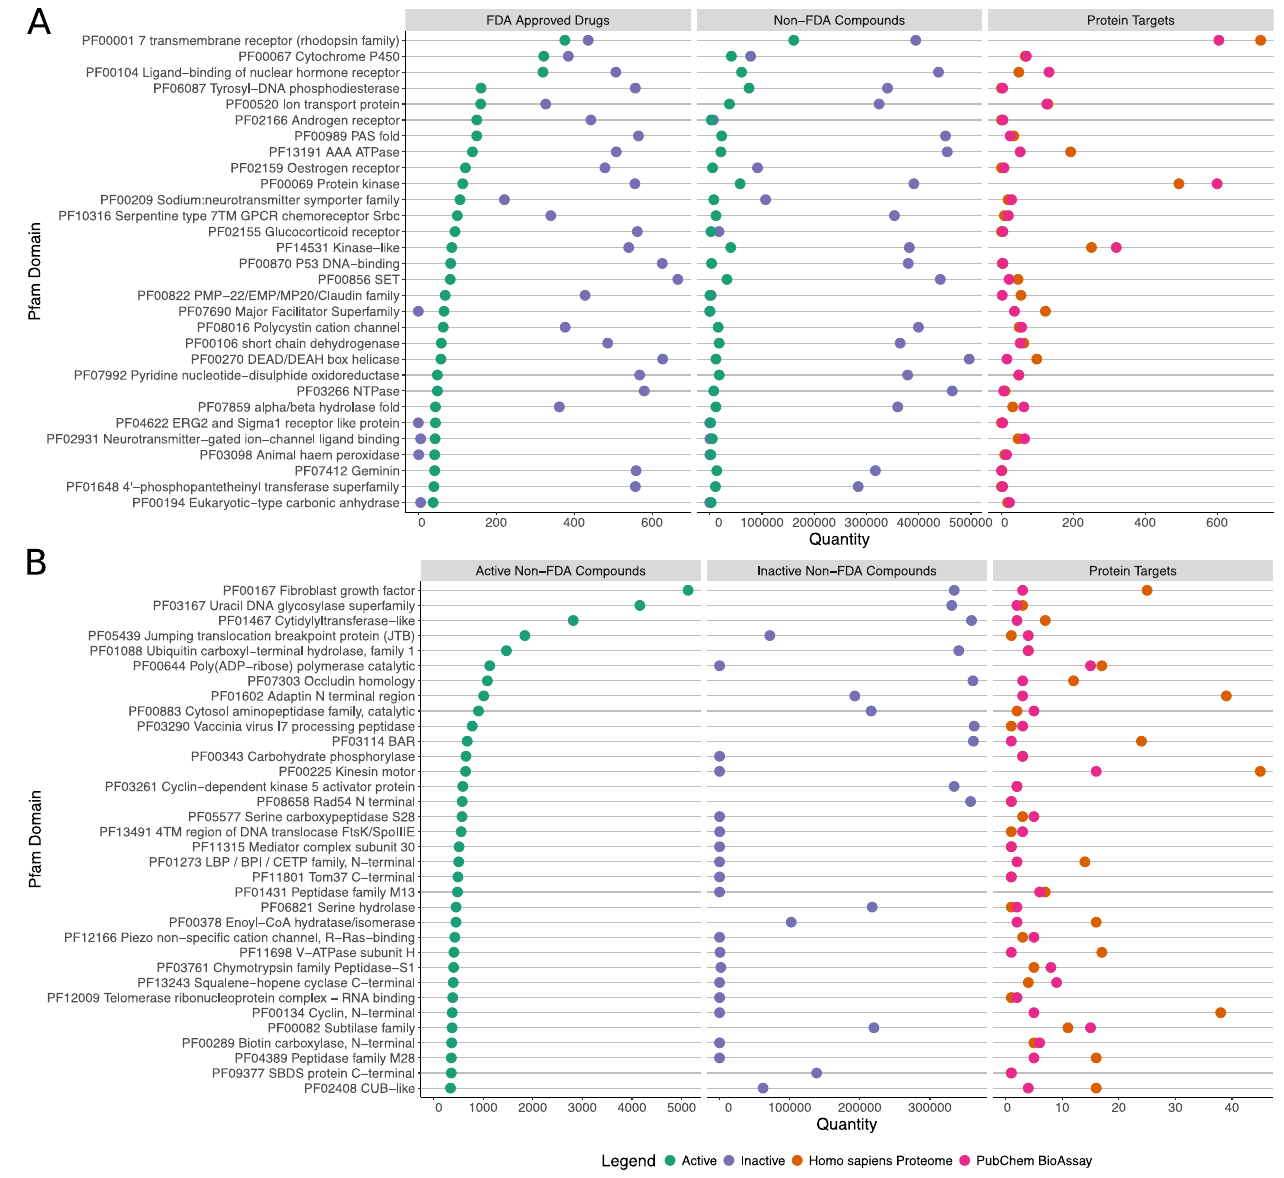
Fig 3. Frequency of active pubchem bioassay compounds across protein target domains. The target proteins represented in PubChem BioAssay have beenclassifiedby Pfam protein domainspresent in the H. sapiens proteome (vertical axis). We report data for all proteins which encodea Pfam domainpresent in the H. sapiens proteome,even if the assay was performed against a protein from another species. We show here only domainswith at least 100 amino acid residues in the homology model, to avoid small repeats and domainsunlikely to be drug targets. Additionally,we report for multi-domain clusters only the most frequent and functionally descriptivemembers as outlinedin the Methods section (see “De-duplication of SingleDomainClusters”). Domainsof unknownfunction (DUFs) were also removedsince they are rarely the functional target of bioassays. The quantity of targets with each domainamong the PubChemBioAssay data, and within the H. sapiens proteome(all proteins, includingthose not screened in PubChemBioAssay) are shown on the right in both plots. (A) The top 30 Pfam domains with the greatest number of active FDA approved drugs, in decreasing order. (B) The top 34 Pfam domainswith the greatest numberof non-FDA compounds,but no active FDA approveddrugs, in decreasing order. A full table is provided in the S2 File of SupportingInformation includingthe numberof active compoundsfor each domain,non- H. sapiens domains,all domainsoccurringon the same proteins, and domainswith less than 100 residues.